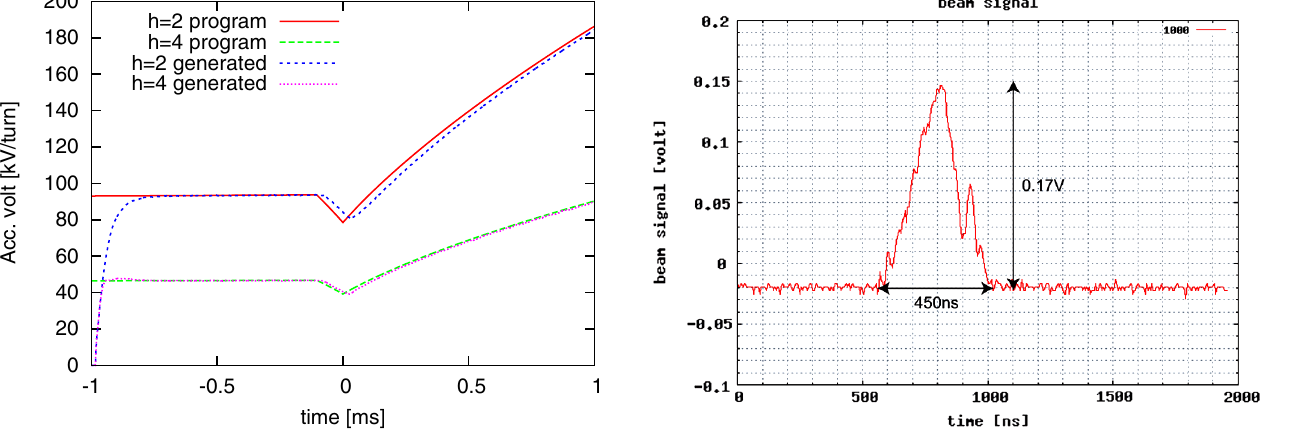
FIG. 17. (Color) Program and generated voltages, near the in- jection period.